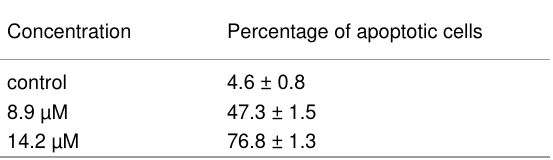
Table 5: Percent apoptotic cells a in presence and absence of 11b by FITC-Annexin-V/PI staining by FACs analysis.